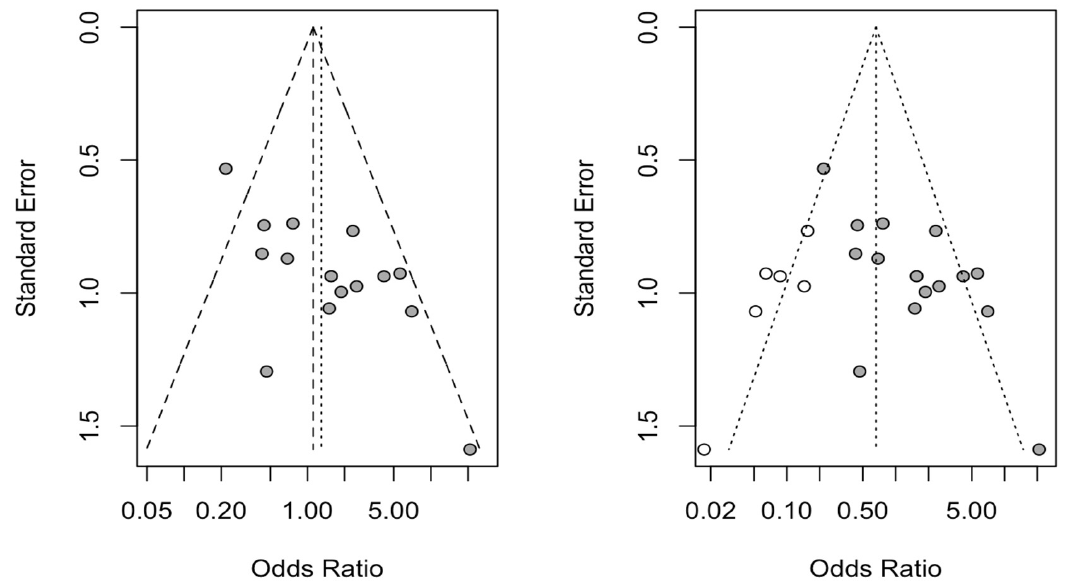
Figure 8. Initial funnel plot after trim and fill adjustment of OR of periapical healing among guided tissue regeneration techniques.